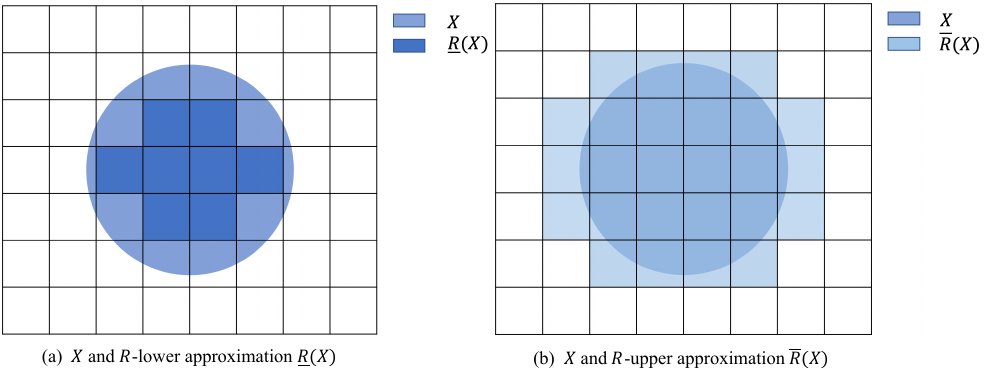
Figure 1. The relationship between R -upper and R -lower approximations of set X